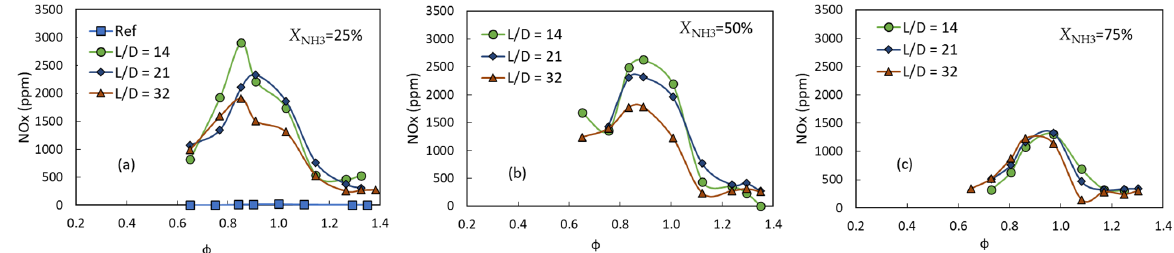
Figure 7. Measured NOx concentrations at different equivalence ratios for different mixing length ratios at a fixed ammonia fraction, e.g., ( a ) 25, ( b ) 50 and ( c ) 75%. The reference case in ( a ) is for a neat methane-air mixture at L / D = 32.